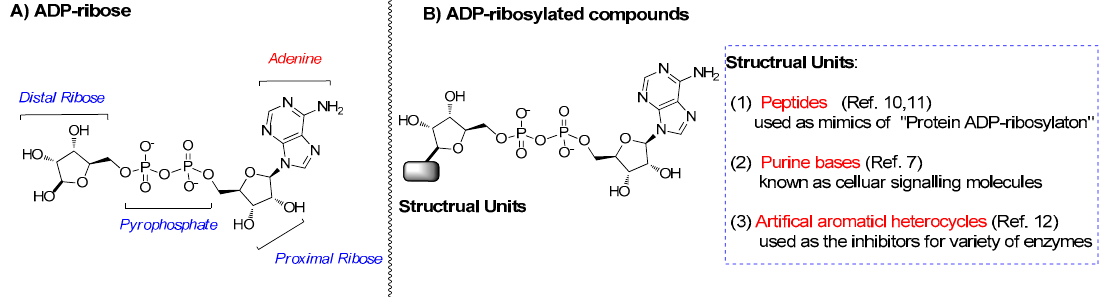
Figure 1. ADP-ribose and ADP-ribosylated compounds. ( A ) Structure of ADP-ribose; ( B ) Structurally and functionally diverse ADP-ribosylated compounds.